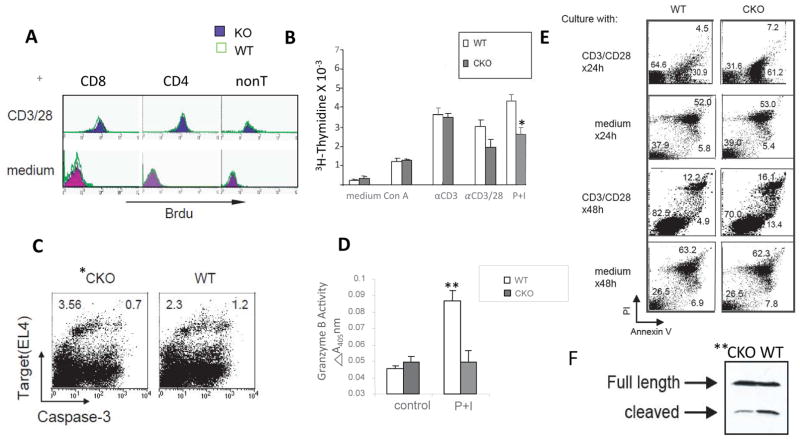
Smyd1C-deficient splenocytes undergo activation-induced apoptosis and CTL killingA. CKO splenocytes proliferate normally as measured by BrdU incorporation. CD3+ CD28-stimulated WT (green) and CKO (purple) splenocytes were tested for proliferation following intracellular incorporation over 12 h with BrdU (10 uM). CD4 and CD8 cells were then isolated and stained with respective antibodies for FACS analyses. The Y axis is plotted as Mean Fluorescence Intensity (MFI); WT, green; CKO, purple. B. CKO thymocyte proliferation is slightly reduced in response to PMA + Ionomycin (P+I) stimulation, Cells were stimulated with ConA, anti (α)-CD3, α-CD3 + α-CD8 or P+I for 3 days and then analyzing for 3H-thymidine incorporation as described in Materials and Methods. *p<0.07. C.
Smyd1C CKO cells are deficient in activation-induced apoptosis. CD8 splenocytes were isolated from WT and CKO mice 8 d after infection of mice with LCMV (detailed in Methods and Materials). EL-4 cells were labeled and pulsed with the LCMV peptide NP396–404 for 1h and then incubated with splenocytes at an EL-4 to splenocyte ration of 25:1) for 2 h. After 30 min incubation with a cell-permeable, fluorogenic caspase substrate, cells were analyzed by flow cytometry. Shown is a representative plot of 3 experimental replicates (p<0.05). D. Release of BLT esterase following stimulation with P+I for 4 h is impaired in CKO splenocytes. Error bars show averages of 3 representative experiments; **p<0.01. E.
Smyd1C-deficient splenocytes actively undergo apoptosis in response to TCR stimulation. Magnetic sorted CD8 cells from WT and CKO mice were incubated with anti-CD3 and anti-CD28 or medium alone. Cells were stained with annexin V and propidium iodide (PI) at the indicated time points and analyzed by FACS. Data shown are representative of 3 independent experiments. F. Activated Smyd1C-deficient CD8+ splenocytes are defective in killing. Cells fractionated in panel A were harvested at 48 h of culture, and whole cell lysates of WT and CKO CD8+ splenocytes were subjected to Western blotting with anti-caspase 3; upper band represents the full length (uncleaved) and the lower band, the cleaved caspase 3 product. All data are shown as means of 4 independent experiments; **p<0.01.